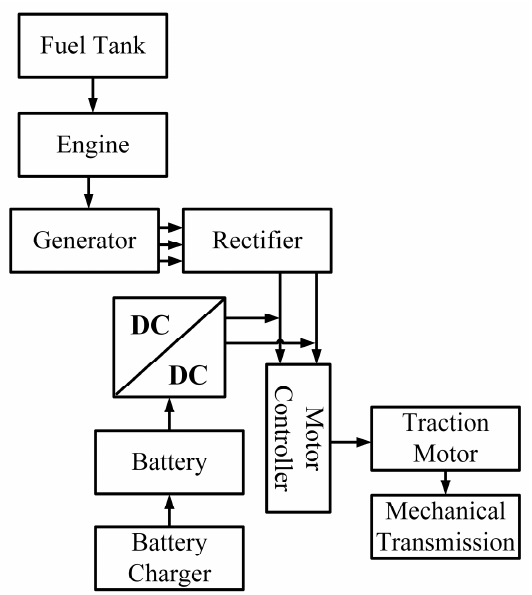
Figure 18. Drive train of series hybrid system. The engine is used to generate electricity only and supply to the motor through a rectifier. Power from the battery goes to the motor through a DC-DC converter [30]. Table 2. Advantages and limitations of series hybrid configuration. Adapted from [8].